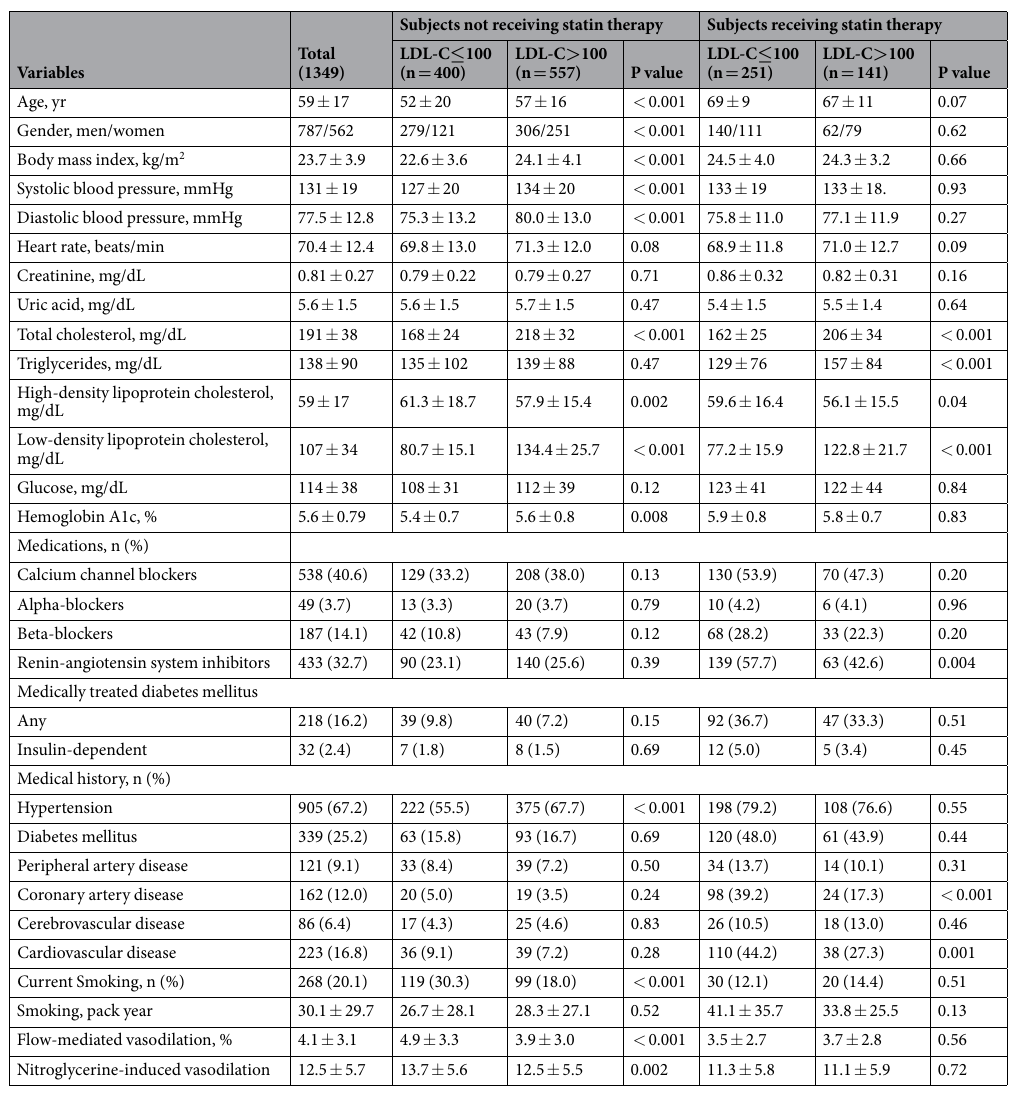
Table 1. Clinical Characteristics of the Subjects in Accordance with LDL-C. LDL-C indicates low-density lipoprotein